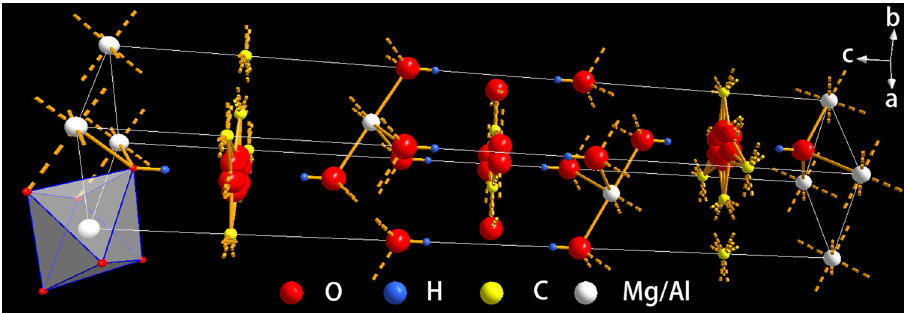
Figure 1: Crystal structure diagram of MgAl – CO 3 – LDH.